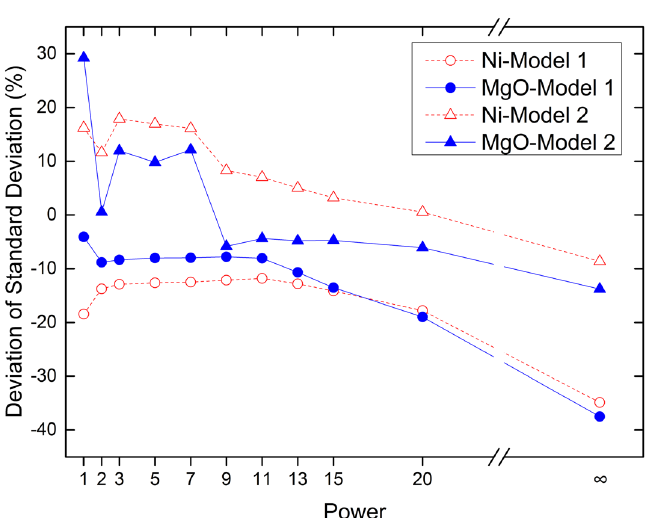
Figure 8. Deviation of ore grade standard